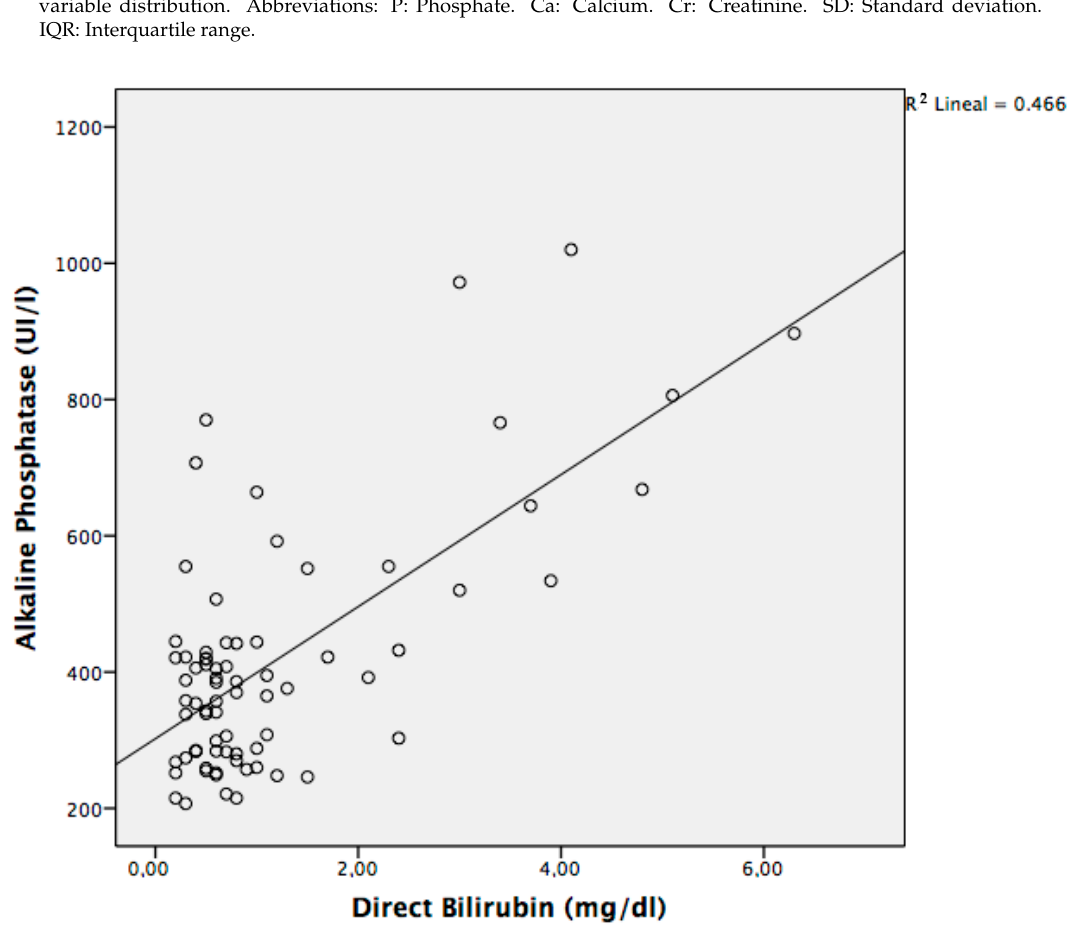
Figure 1. Dispersion graph with the relationship between serum alkaline phosphatase (ALP) and direct bilirubin (DB). Changes in the levels of DB are associated with changes in serum ALP values, with a R 2 coefficient of determination of 0.466. Table 1. Biochemical determinations from preterm infants in the Retrospective Group (RG). Comparison of the different biochemical values according to cholestasis and non-cholestasis criteria.